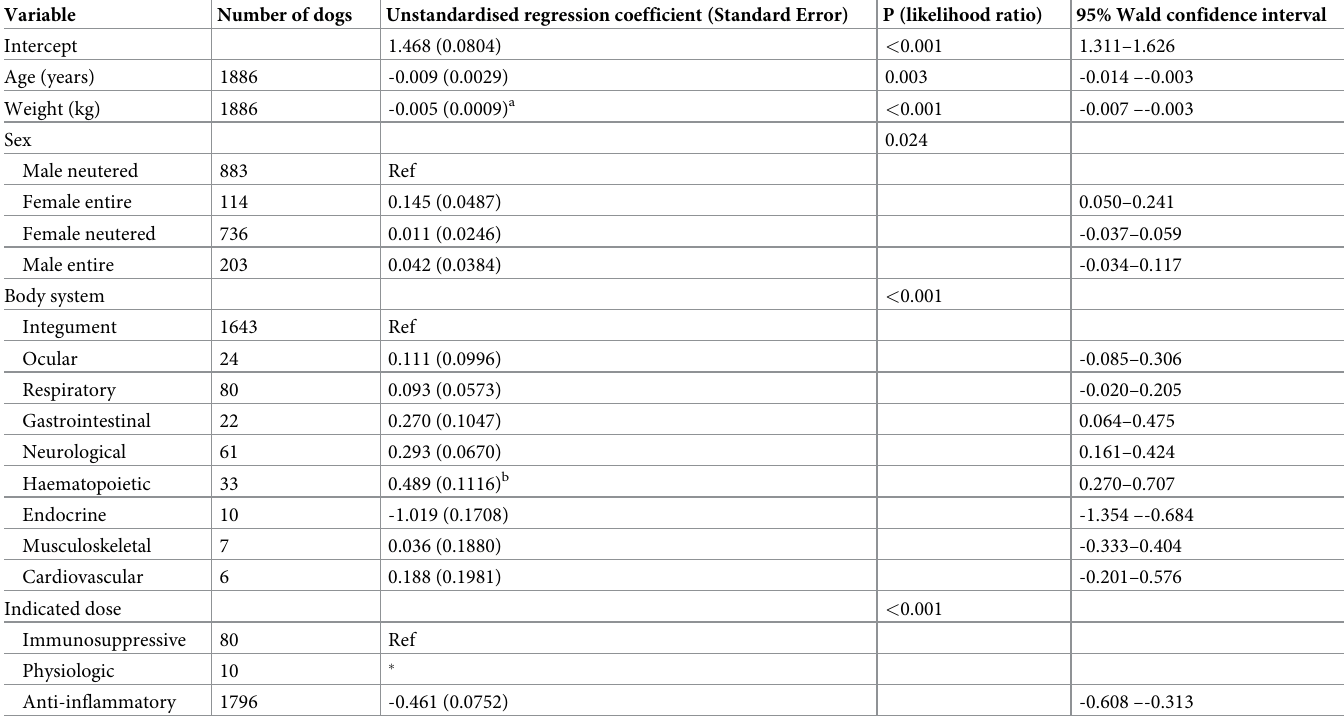
Table 6. Multivariable analysis for variables associated with prednisolone dose in